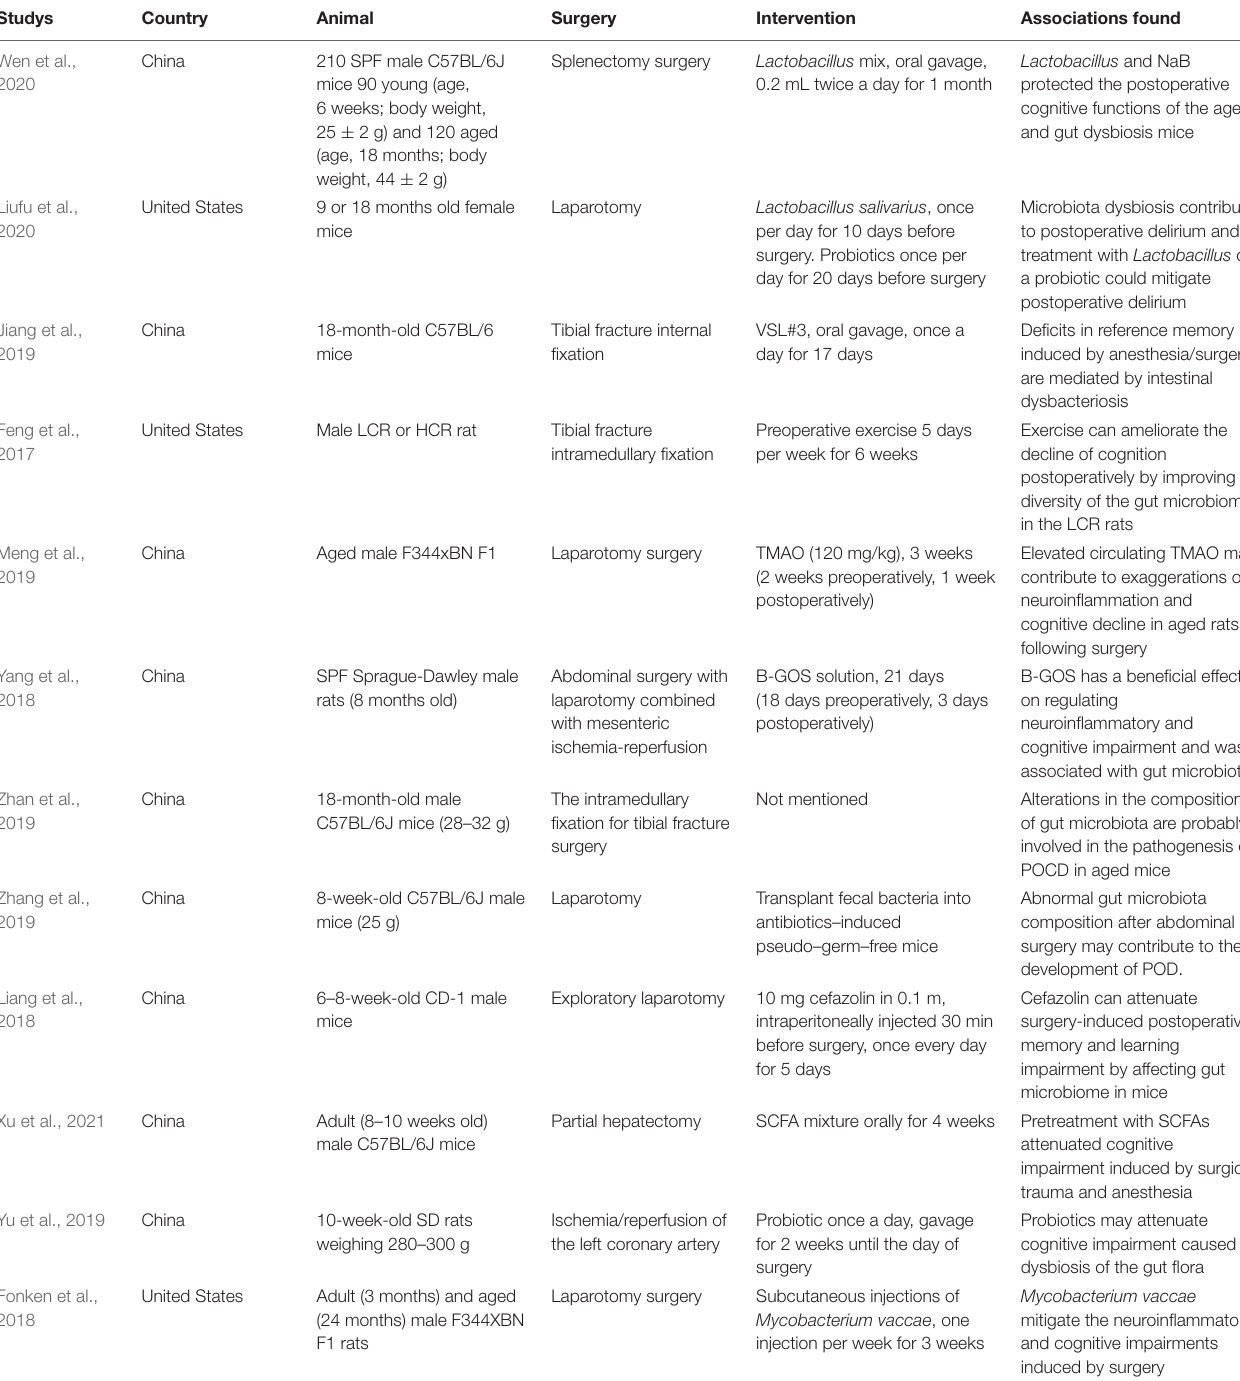
TABLE 1 | Characteristics of included studies on the relationship between gut microbiota and